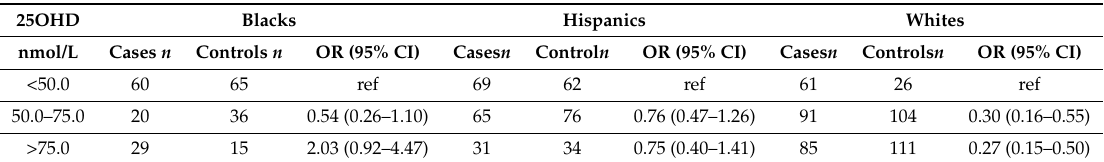
Table 3. Matched pairs analysis: Odds Ratios of Multiple Sclerosis by Threshold Values of Serum 25–Hydroxyvitamin D among Blacks, Hispanics and Whites.